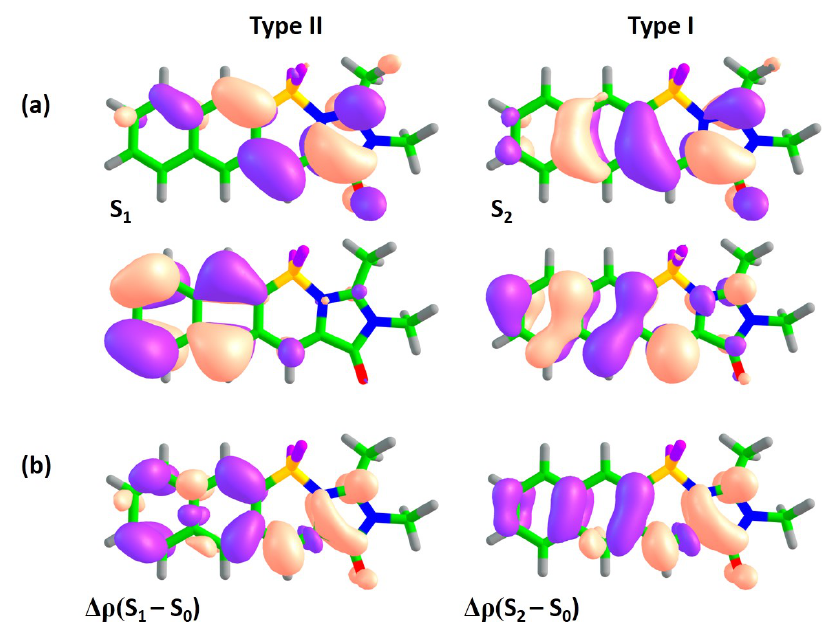
Figure 6. XMCQDPT2 natural orbitals actively involved in the S 0 –S 1 and S 0 –S 2 transitions ( a ) and the corresponding differential electron densities ∆ ρ ( b ) for compound 1C . For each state, the excitation is directed from the lower orbital to the higher orbital. The color code stands for negative and positive ∆ ρ values depicted in blue and red,